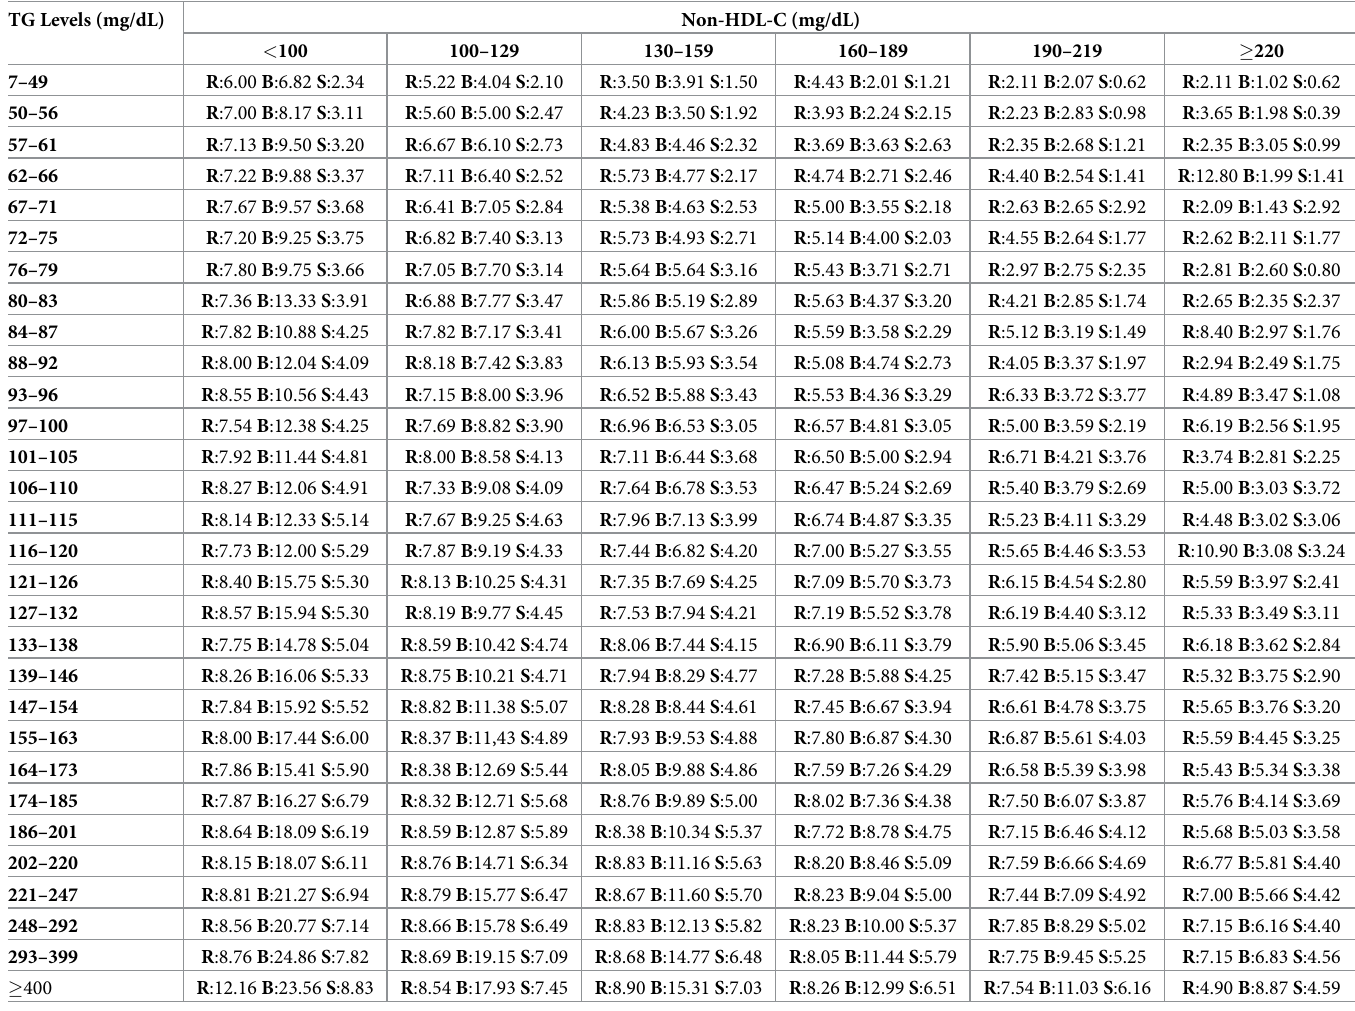
Table 2. Median statistics for the ratio of triglycerides to very low-density lipoprotein cholesterol by the cross table of non-high-density lipoprotein cholesterol and triglycerides calculated from the Turkish population (calculated for each direct assay method for 180-cell